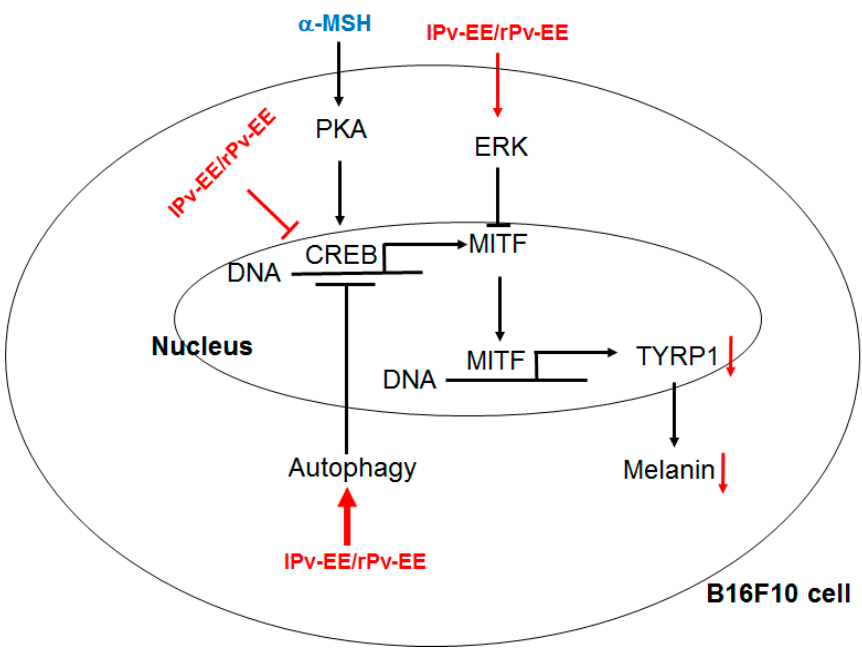
Figure 5. Putative inhibitory pathway of lPv-EE and rPv-EE.